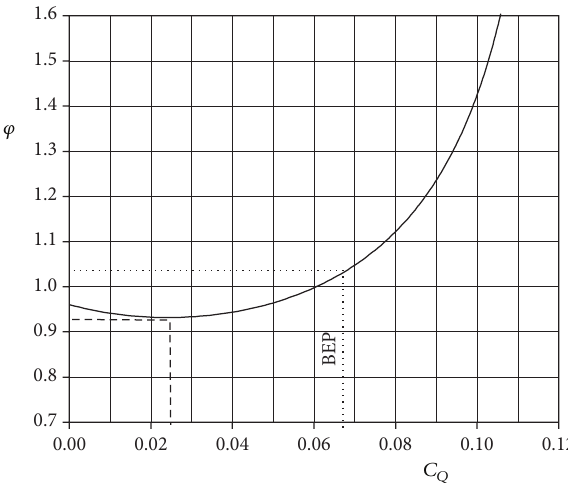
Figure 12: Speed coefficient variation with pump discharge coeffi- cient.